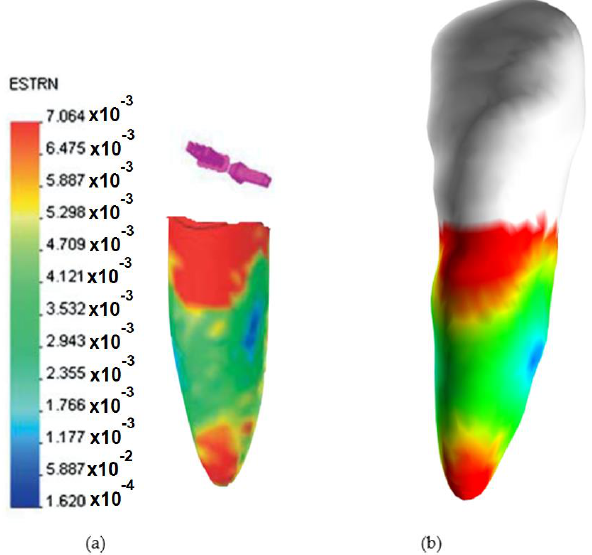
Figure 9. Comparison of equivalent strain [ESTRN] between a FEM study ( a ) by Field et al. [12] and ( b ) the proposed model. The colormap was adjusted to that used in [9] to allow convenient compar- ison and the same PDL properties as in [9], that is, ( 𝐸 = 1.18 Mpa,𝜈 = 0.45 ), the applied orthodontic force of 0.5 N (purple) was located at about the same location and angle as depicted in the reference. In both cases, the major strains are observed in the alveolar crest and the apex, as expected. Figure 9a provided courtesy of Prof. Michael Swain.